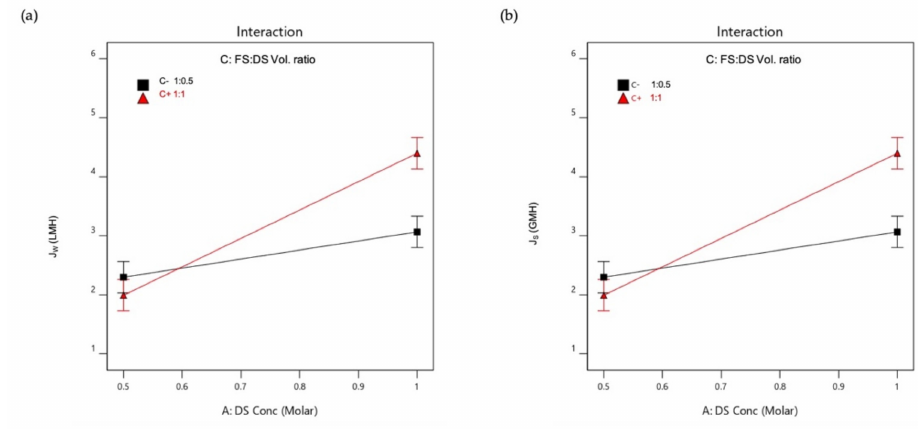
Figure 5. Interactions plot for ( a ) Average water flux, J W ; ( b ) Reverse salt flux, J S .